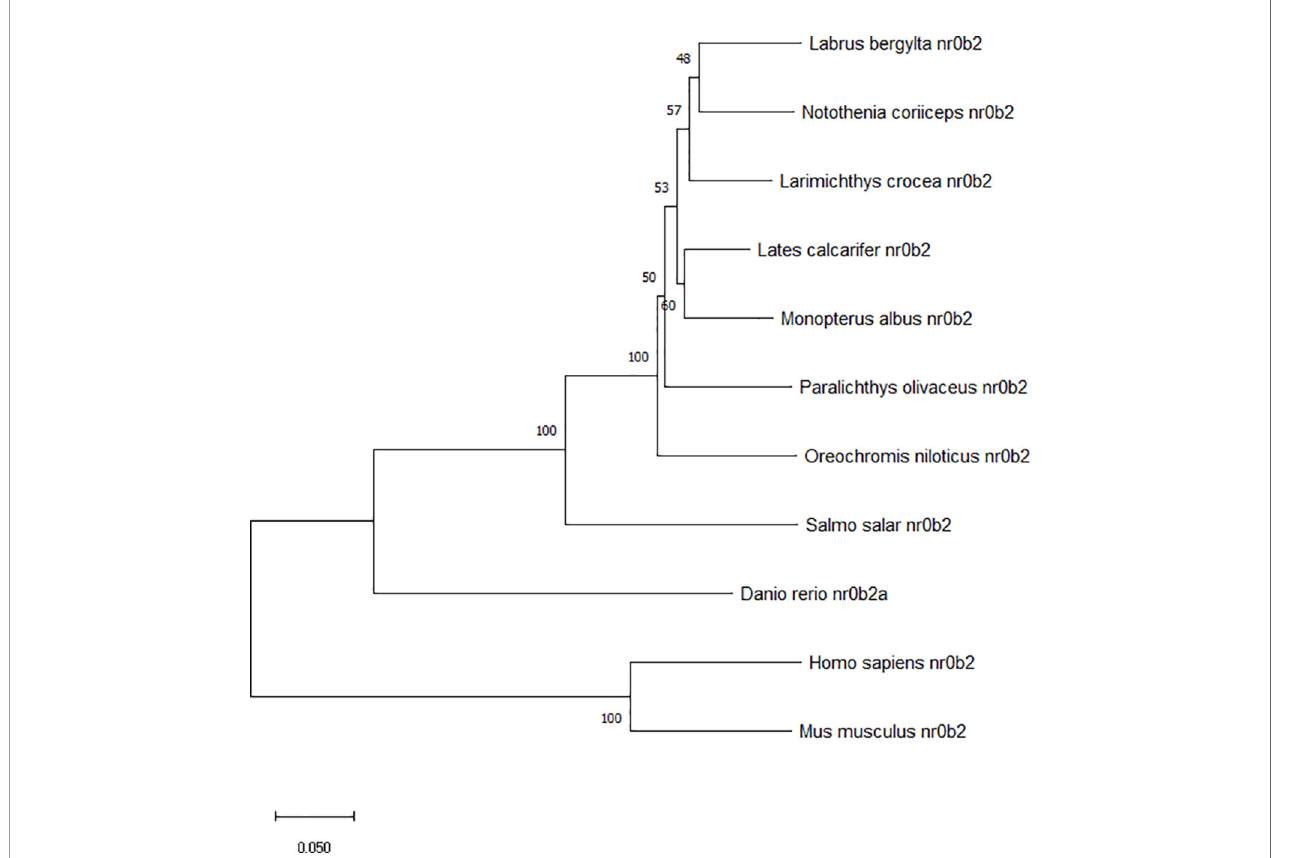
FIGURE 3 | Phylogenetic tree of large yellow croaker SHP with other vertebrate counterparts. The horizontal branch length is proportional amino acid substitution rate per site. The numbers represent the frequencies with which the tree topology presented here was replicated after 1000 bootstrap iterations.